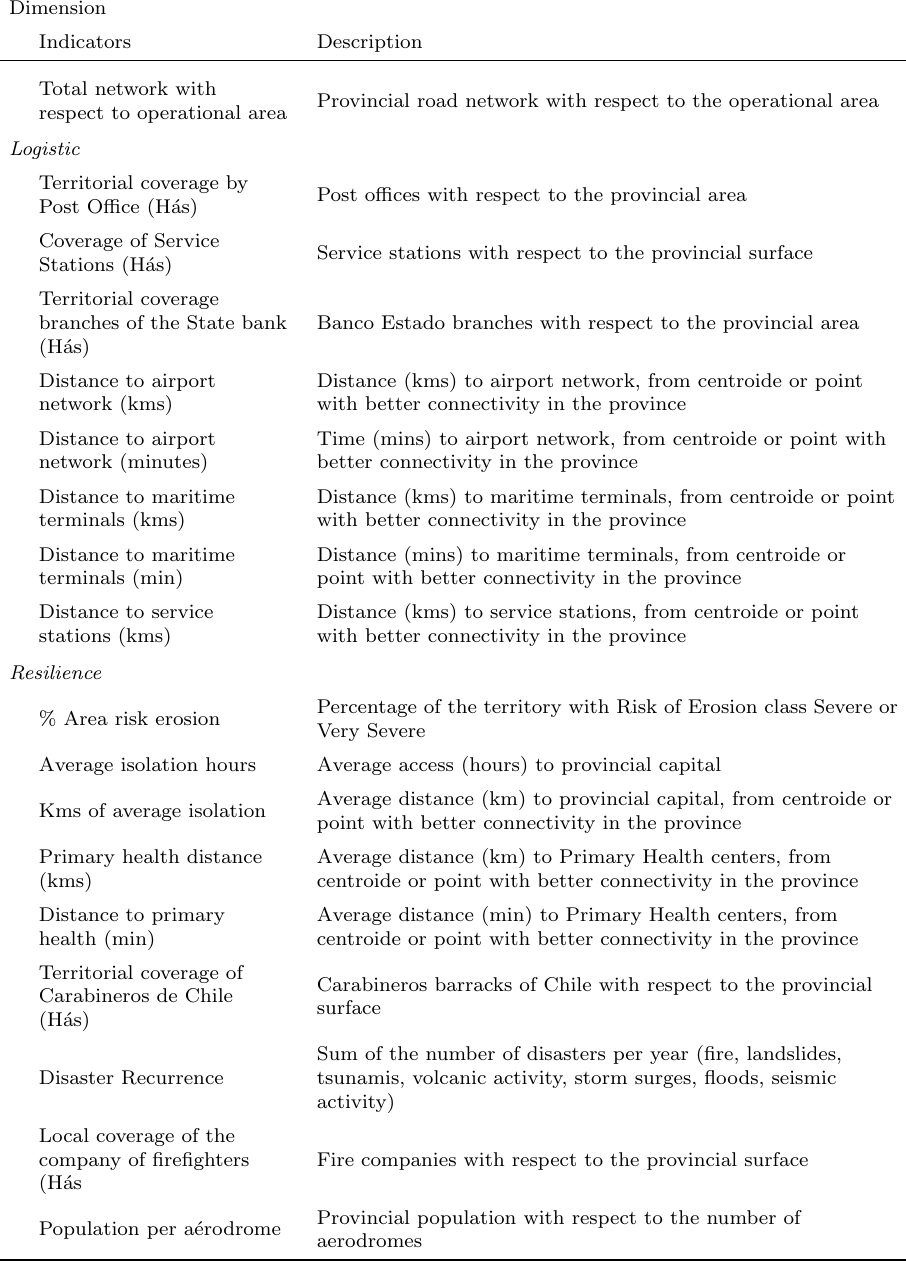
Table A.1: List of indicators